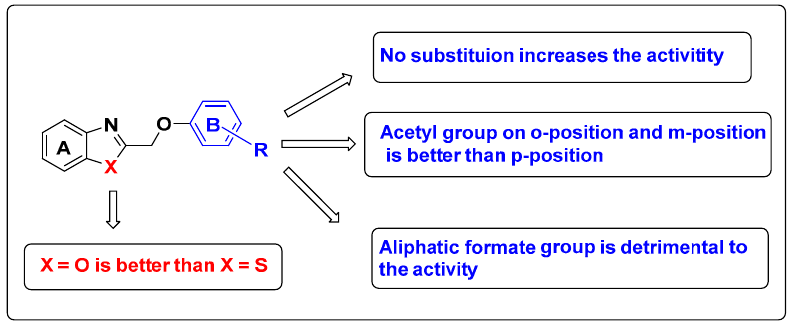
Figure 3. Structure activity relationship of the synthesized compounds.